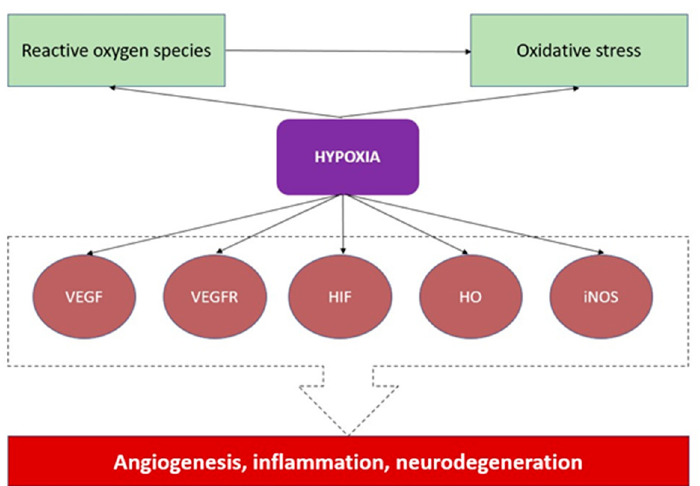
Figure 1. The influence of hypoxia in the contexts of angiogenic markers of homeostasis. Abbrevia- tions: VEGF, vascular endothelial growth factor; VEGFR, vascular endothelial growth factor recep- tor; HIF, hypoxia-inducible factor; HO, heme oxygenase; iNOS, inducible nitric oxide synthase.